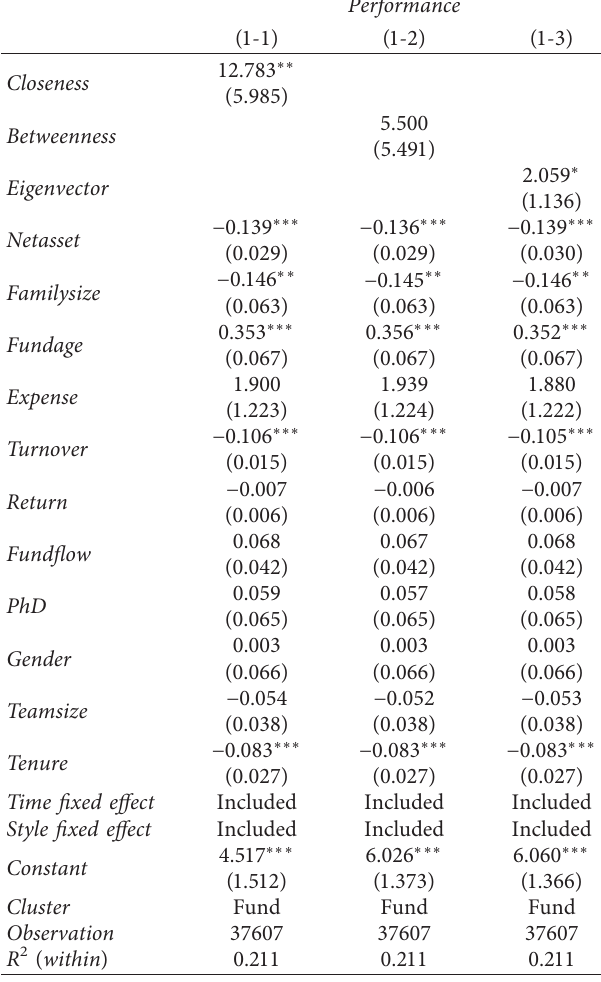
Table 2: The effect of fund network centrality on investment